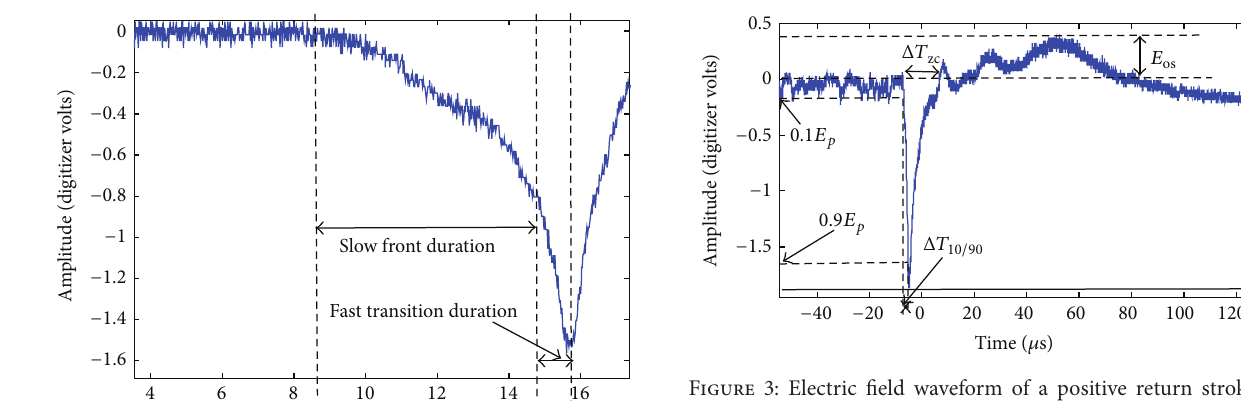
Figure 3: Electric field waveform of a positive return stroke on (zero-crossing time), December 6, 2012, 3:48:06 pm defining Δ𝑇 zc 𝐸 𝐸 (opposite polarity 𝑝 (peak amplitude), and os